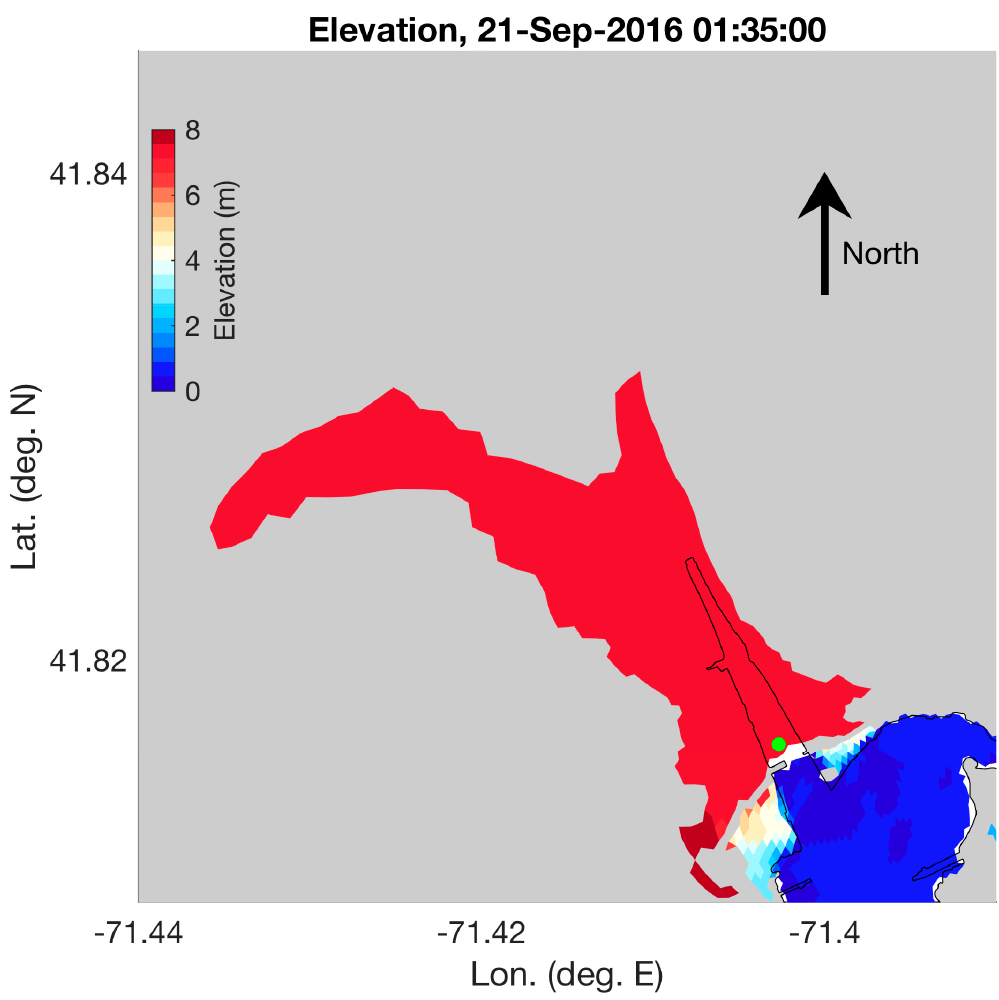
Figure 13. Water surface elevation in the Providence area at the end of the Rhody simulation including river discharge and the presence of the FPHB. The coastline is represented by the black line, and colored areas shoreward of the coastline represent areas experiencing overland flooding. The green dot is the location north of the FPHB at which a time series of surface elevation is shown in Figure 12 (bottom).